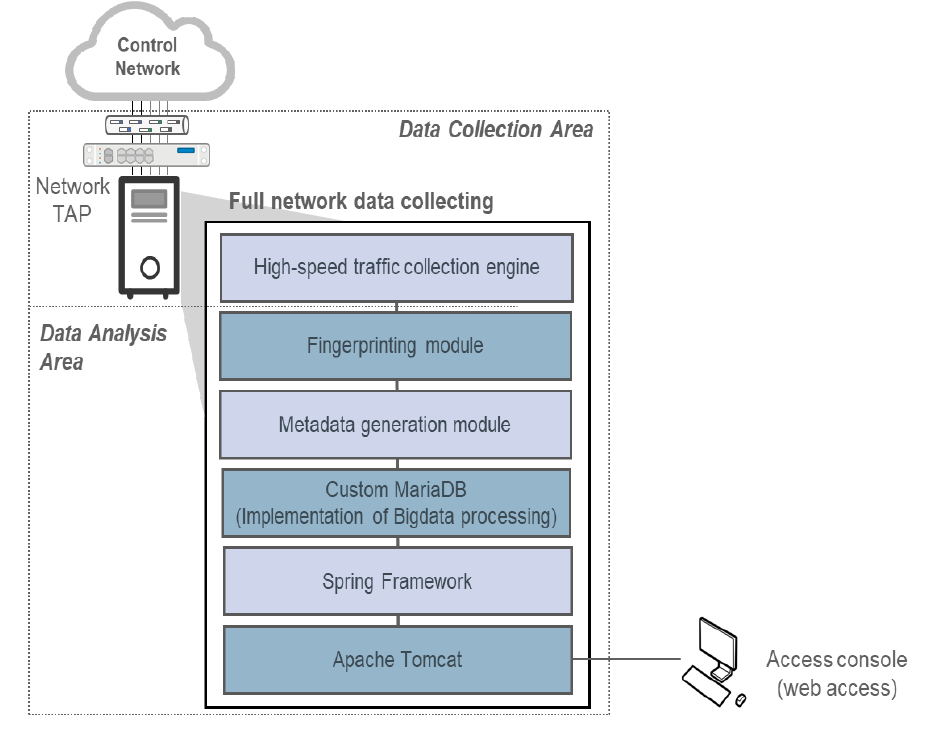
Figure 10. Test environment configuration .